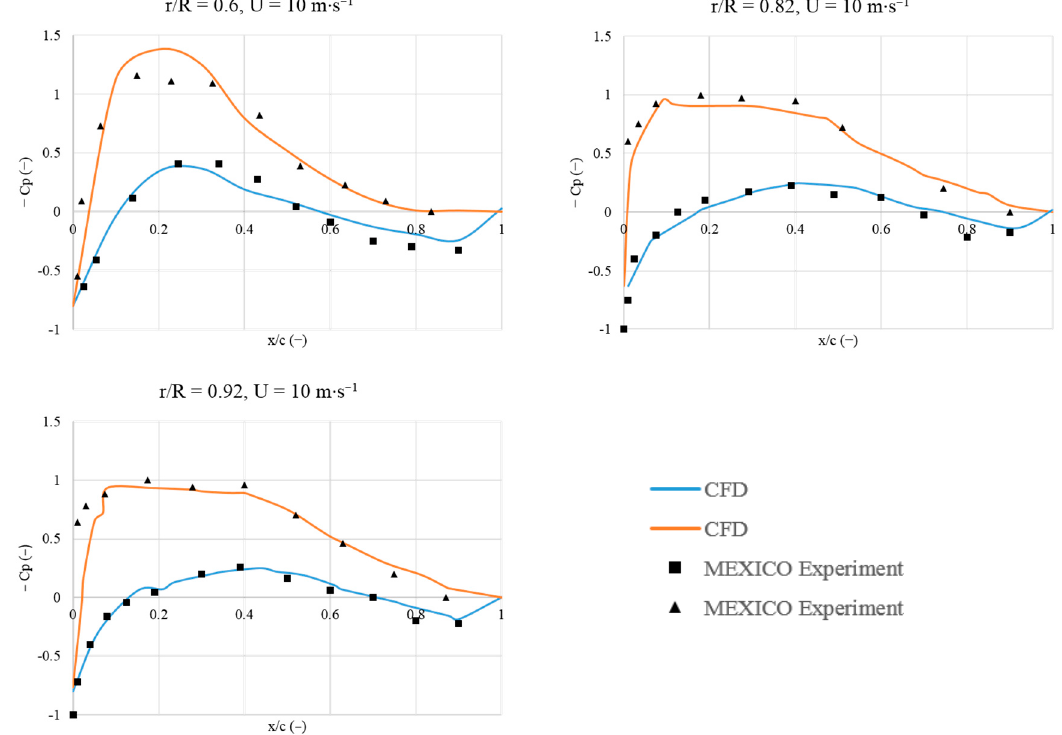
Figure 7. Normalized pressure coefficient on the blades for U = 10 m ∙ s − 1 , TSR = 10 and θ = − 2.3°.